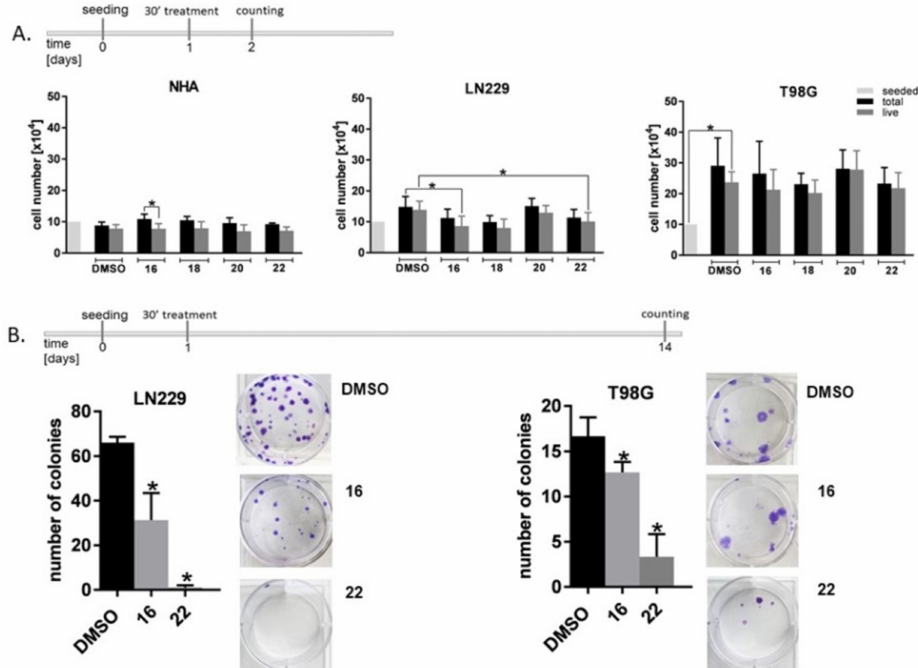
Figure 8. Susceptibility of NHA and GBM cells LN229 and T98G to treatment with dendrimers. ( A ) NHA, LN229, and T98G cells were treated either with 5 µ M dendrimers or DMSO according to a scheme presented in upper panel. Subsequently, the cells were counted and the results are shown in lower panel. * p < 0.05 ( T -test). ( B ) LN229 and T98G cells were treated either with 5 µ M dendrimers ( 16 or 22 ) or DMSO according to a scheme presented in upper panel. Subsequently, the colonies were counted and the results, together with representative pictures, are shown in lower panel. * p < 0.05 vs. DMSO-treated cells ( T